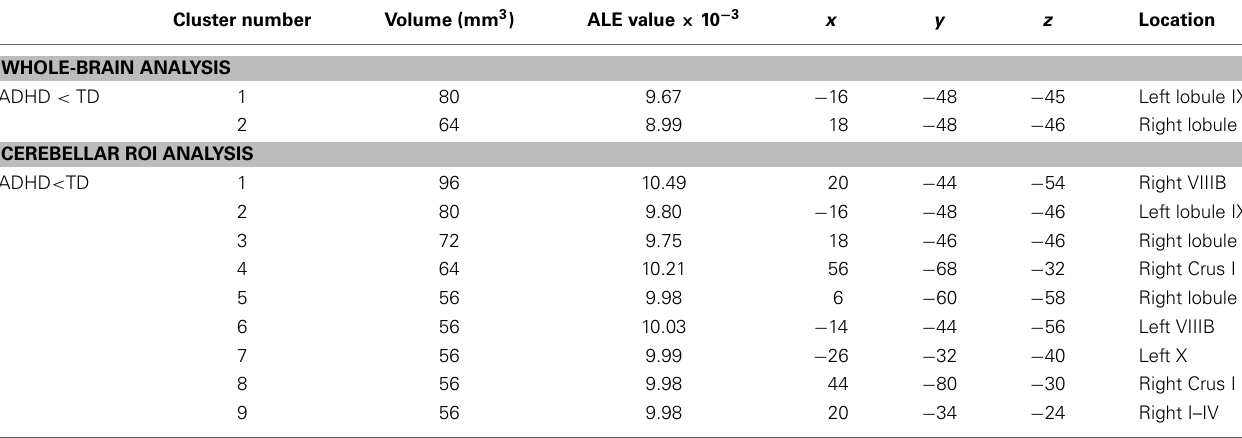
Table 4 | GM differences in ADHD: whole brain and cerebellar-only analyses.